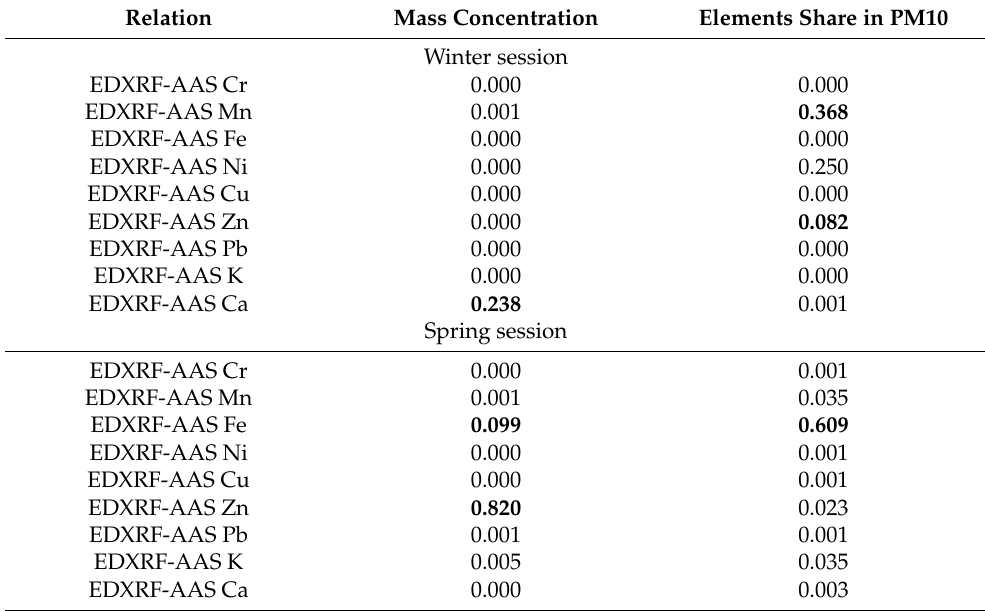
Table 7. EDXRF-AAS p -values of Wilcoxon test for winter and spring sessions. Bold values indicate that the results are significant with p < 0.05.